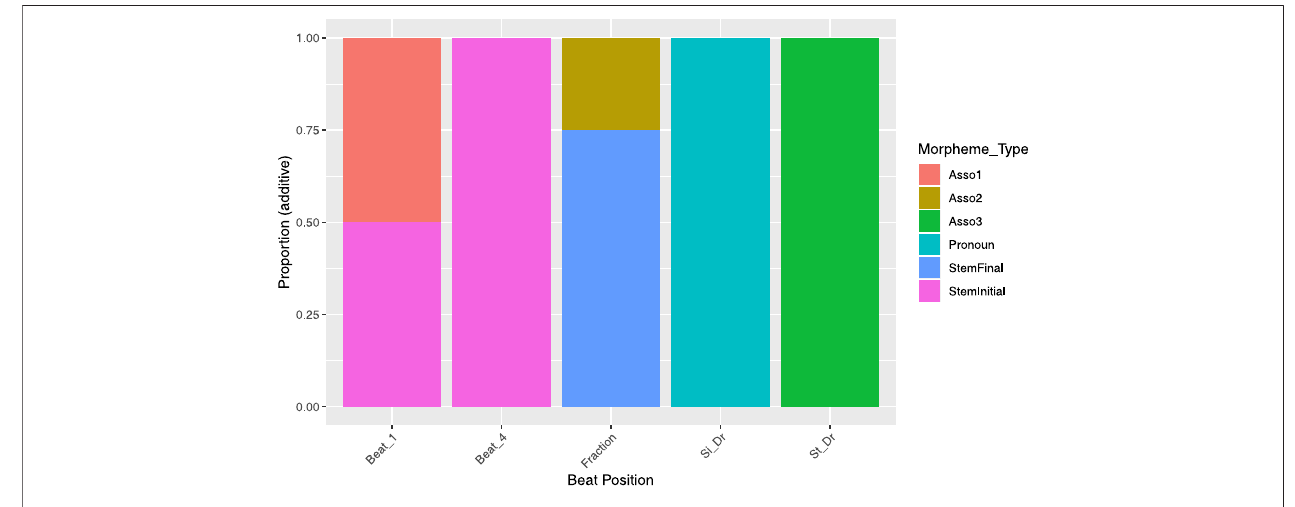
FIGURE 8 | Alignment of syllables by morpheme type in the opening lines/chorus of Song 1 represented as proportions of